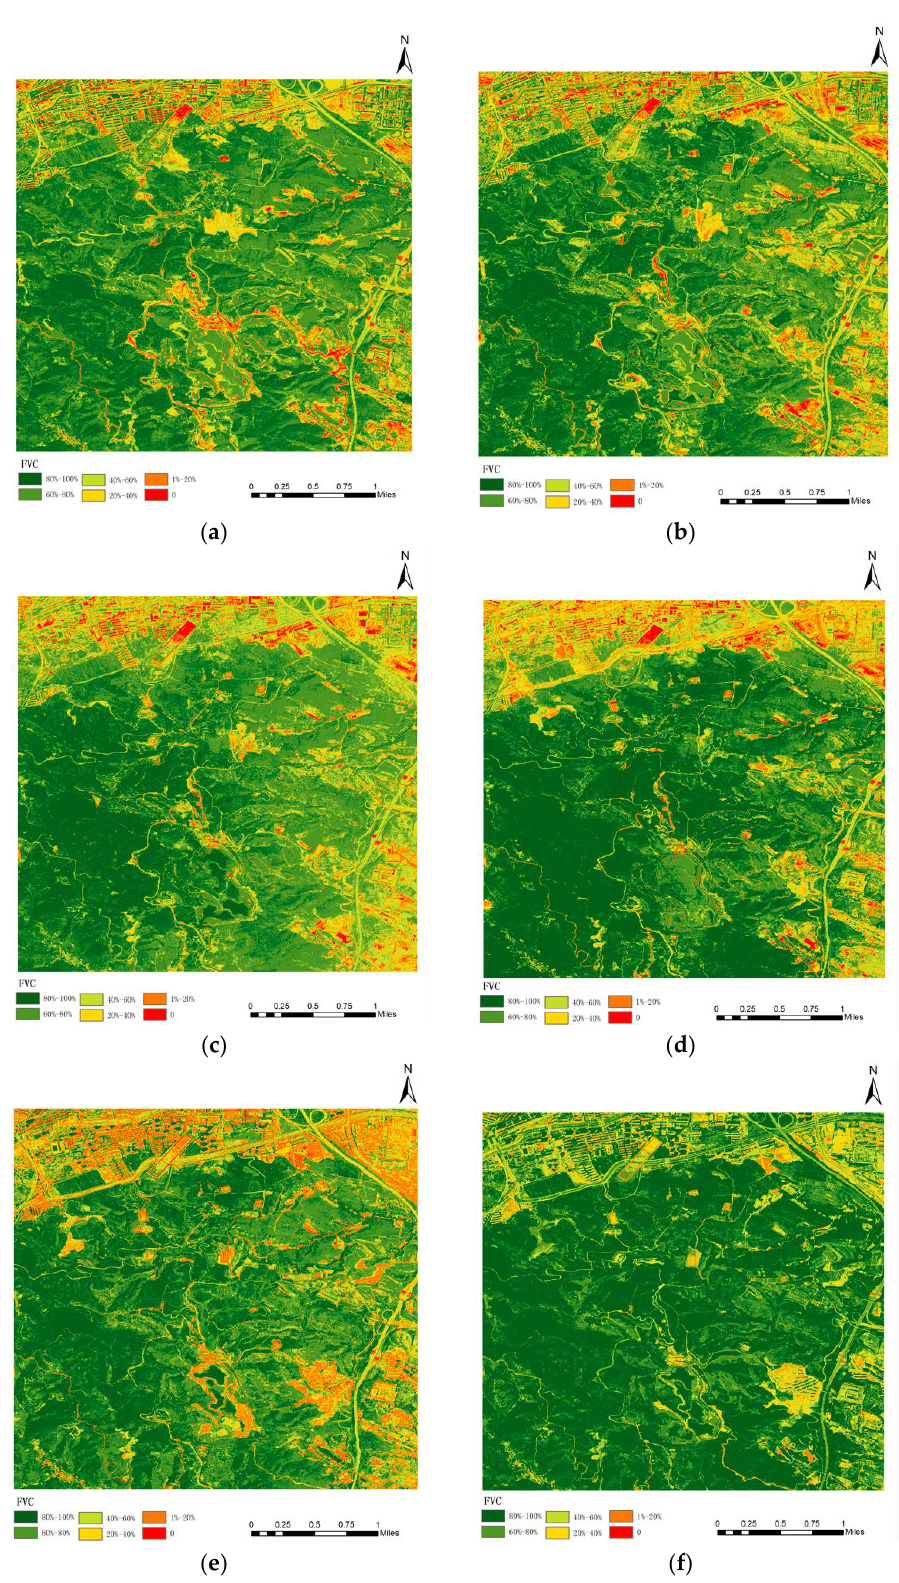
Figure 6. The CIVE model vegetation coverage extraction results. ( a ) 17 August 2013; ( b ) 16